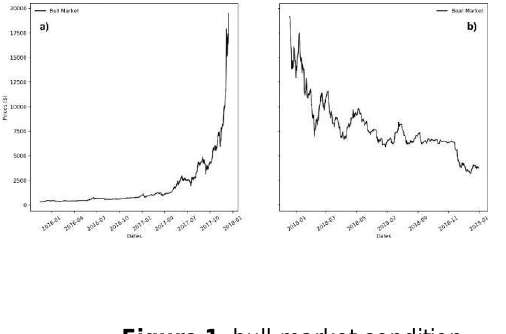
Figure 1. bull-market condition Figure 2: bear-market